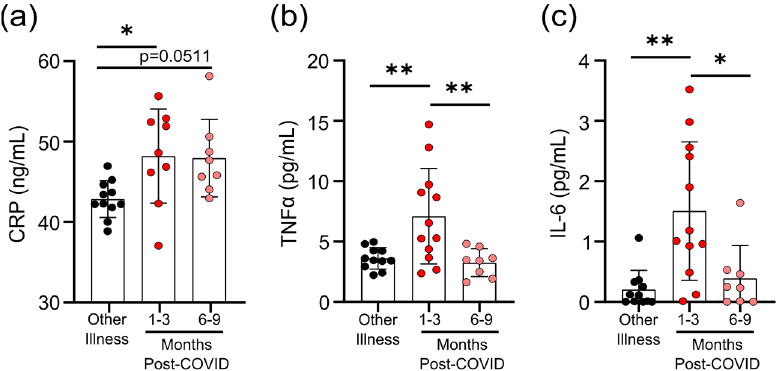
Figure 2. Transient increases in soluble mediators of inflammation occur after mild SARS-CoV-2 infection. ( a ) CRP levels in serum were higher 1–3 months after mild COVID-19 infection, and there was a trend towards remaining elevated 6–9 months after mild COVID-19 infection, compared to levels observed in seronegative individuals after other respiratory infections. Serum TNF levels ( b ) and IL-6 levels ( c ) were higher 1–3 months after COVID-19 infection, but returned to levels seen in individuals who had other respiratory infections by 6–9 months. Each participant is indicated by a single data point: other respiratory infection n = 11; 1–3 months post-COVID n = 9–12; 6–9 months post-COVID n = 8. Multiple group comparisons were tested using Welch’s One-Way ANOVA and the Games–Howell post-hoc test; bars are presented as mean ± standard deviation. * p < 0.05; ** p < 0.01.